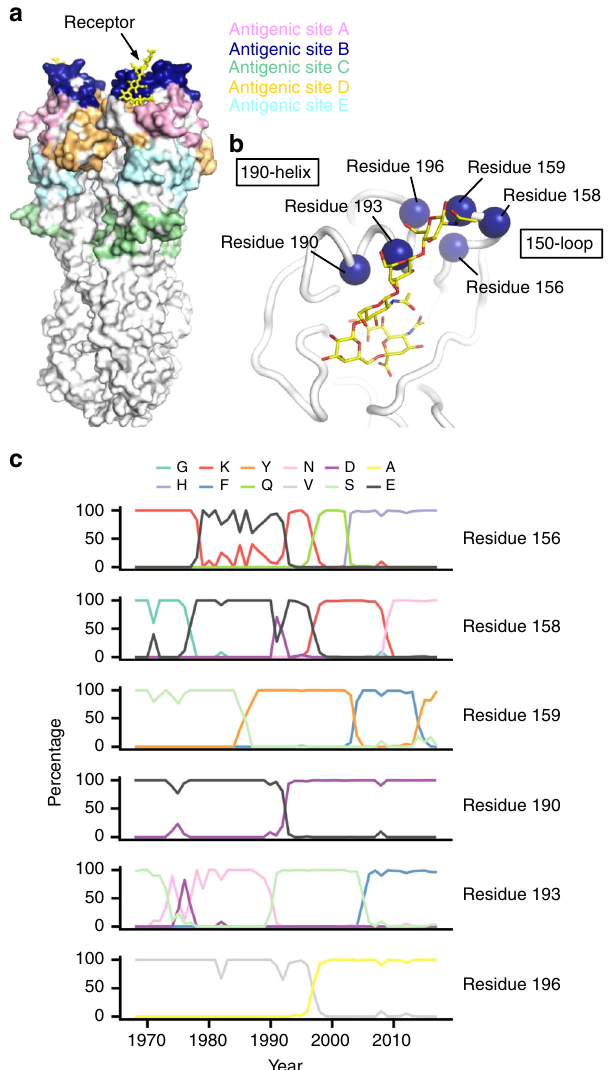
Fig. 1 Natural evolution of antigenic site B in human H3N2 viruses. a The location of the fi ve major antigenic sites (sites A – E) 1 – 3 are shown on the HA trimer structure. The sialic acid receptor is shown in yellow in the receptor- binding site (RBS) that is proximal to and partially encompassing antigenic site B. b The RBS of HA is shown with the six residues of interest in antigenic site B highlighted in blue spheres and the receptor in yellow sticks. c The natural occurrence frequencies of the major amino acid variants, which are de fi ned as having a natural occurrence at ≥ 50% in any given year, at the residues of interest in human H3N2 HA antigenic site B over time are